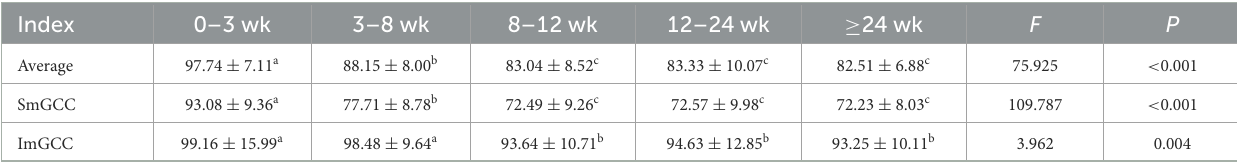
TABLE 3 Changes of mGCC in patients with NAION at different stages.